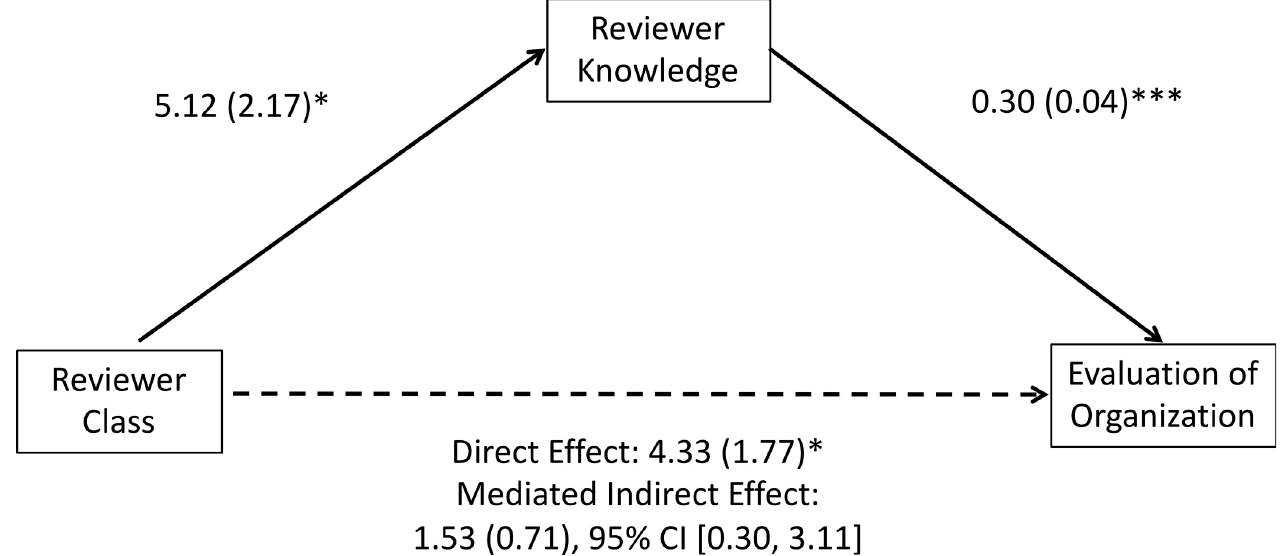
Fig 4. Coefficients and standard errors in a bootstrapping mediation analysis from Study 2, with Organization Status included as a covariate. � indicates p < .05, ��� indicates p <